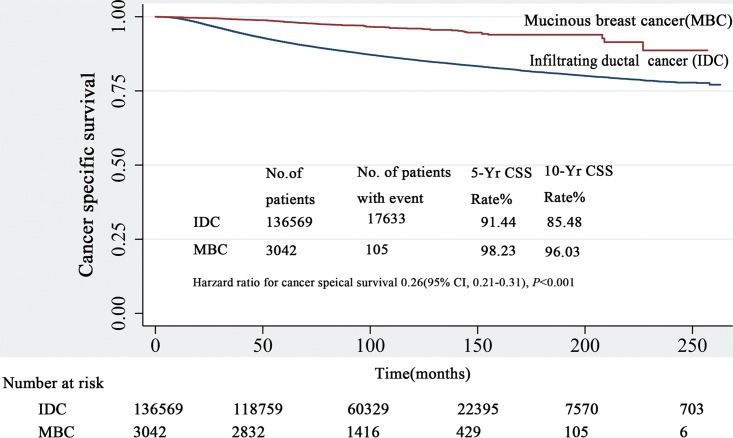
The survival of patients with MBC and IDC by Kaplan-Meier analysis.Patients with MBC obviously had better survival (HR = 0.26; 95% CI, 0.21–0.31, and P < 0.001) with 5- and 10-year CSS rates of 98.23% and 96.03% versus 91.44% and 85.48% in patients with IDC, respectively. IDC: infiltrative ductal cancer; MBC: mucinous breast cancer; and CSS: cancer specific survival.